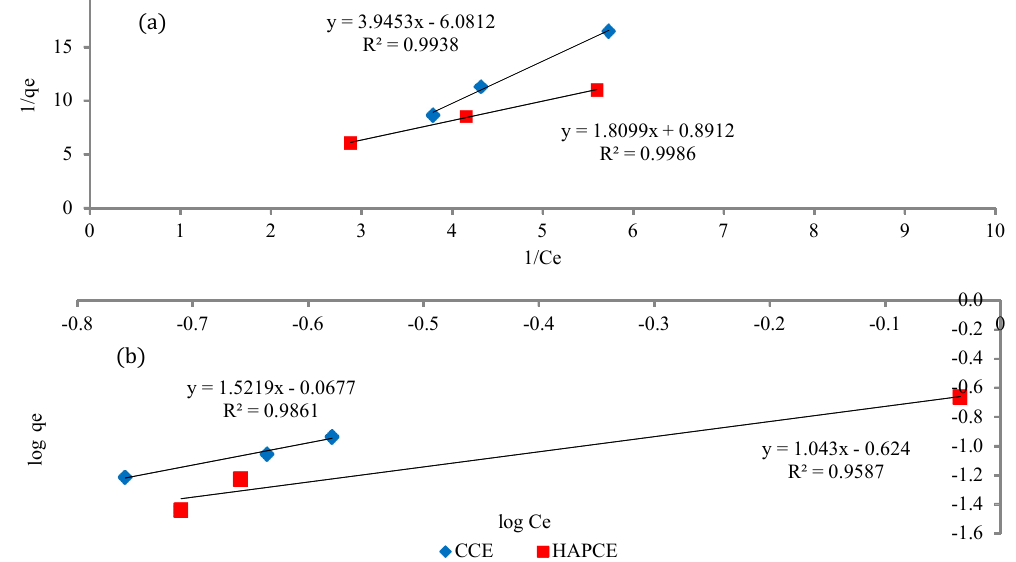
Fig. 4: Isotherm model for CCE and HAPCE (a) Langmuir (b)